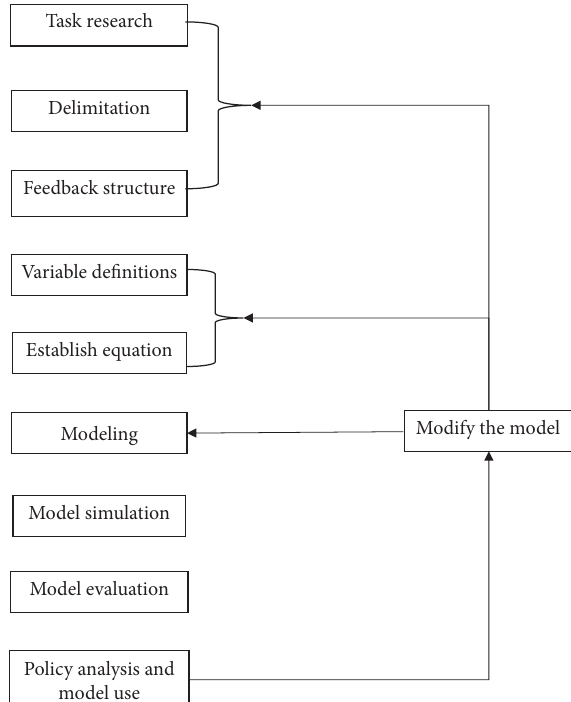
Figure 1: System dynamics modeling